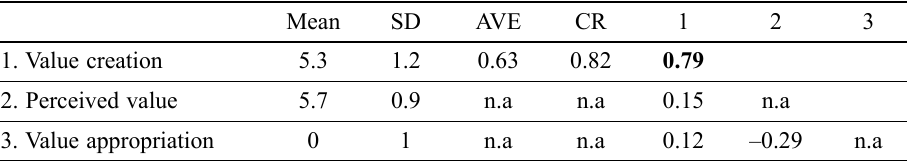
Table 1. Descriptive statistics and discriminant